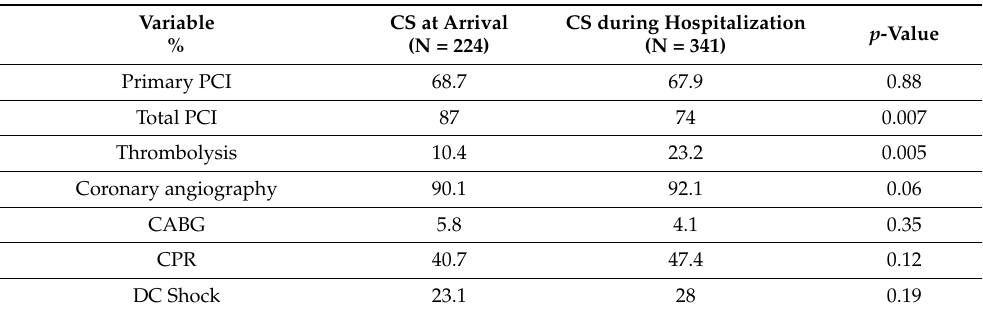
Table 3. Management of patients with ACS and CS at arrival versus patients who developed CS during